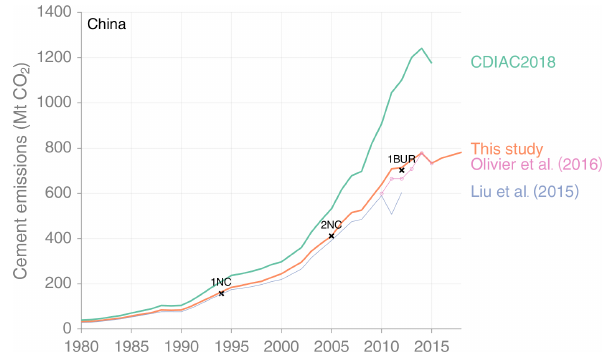
Figure 3. Process emissions from Chinese cement production, 1980–2018 (1NC refers to China’s First National Communication, 2NC the Second National Communication, and 1BUR the First Bi- ennial Update Report). Also shown are estimates from CDIAC (Bo- den et al., 2018), Liu et al. (2015), and EDGAR v4.3.2 FT2015 (Olivier et al., 2016).